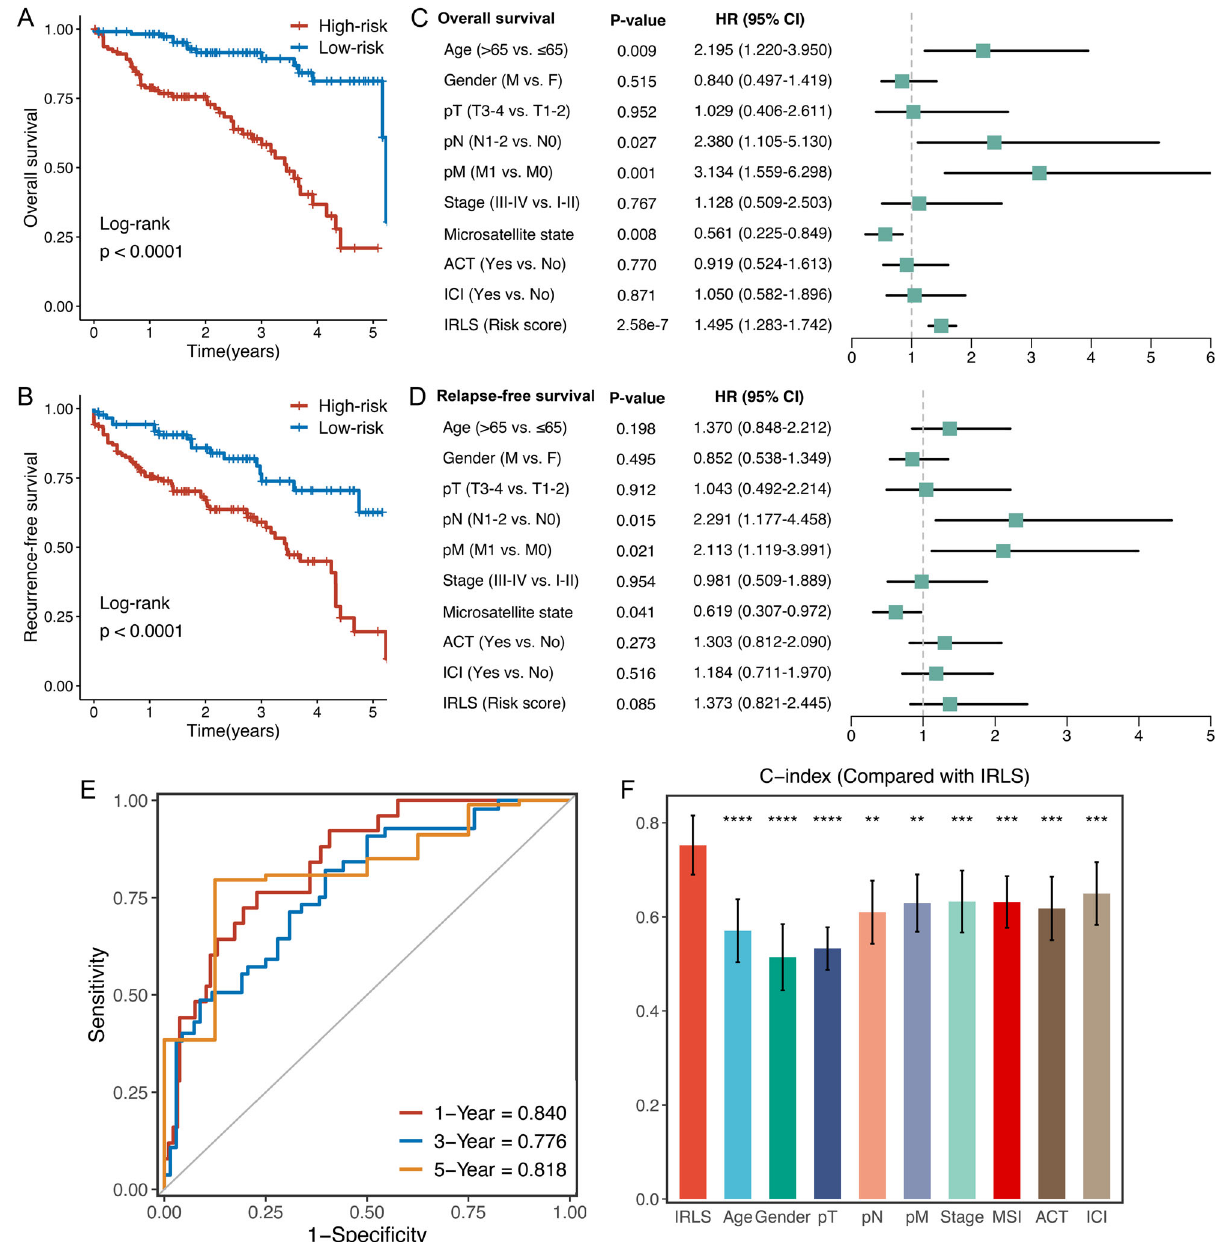
Fig. 5 Validation in a clinical in-house cohort. A , B Kaplan – Meier curves of OS (log-rank test: P = 1.93e − 9) ( A ) and RFS (log-rank test: P = 5.23e − 5) ( B ) according to the IRLS. C , D Multivariable Cox regression analysis of OS ( C ) and RFS ( D ) in our cohort ( n = 232). Statistic test: two-sided Wald test. Data are presented as hazard ratio (HR) ± 95% con fi dence interval [CI]. E Time-dependent ROC analysis for predicting OS at 1, 3, and 5 years. F The performance of IRLS was compared with other clinical and molecular variables in predicting prognosis in our cohort ( n = 232). Statistic tests: two-sided z- score test. Data are presented as mean ± 95% CI. ** P < 0.01; *** P < 0.001; **** P <